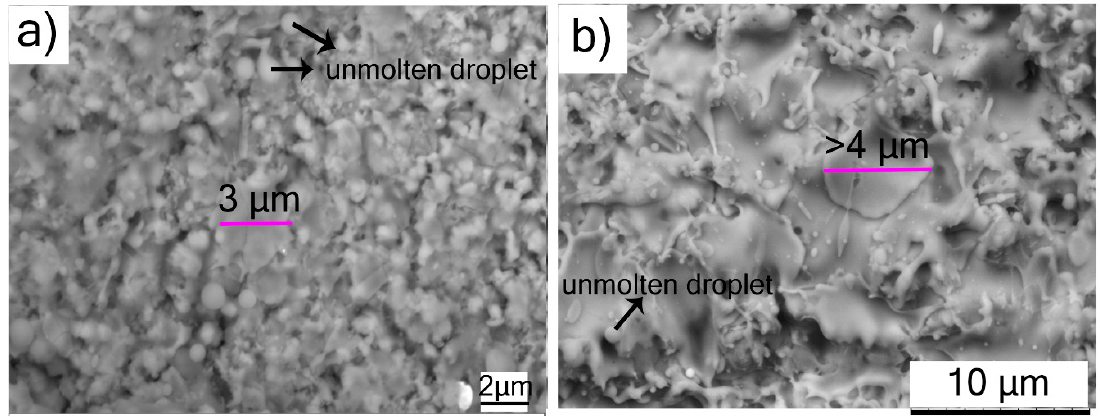
Figure 4. Surface morphology SEM micrographs of SPS-deposited coatings: ( a ) TiC; ( b ) Cr 3 C 2 .